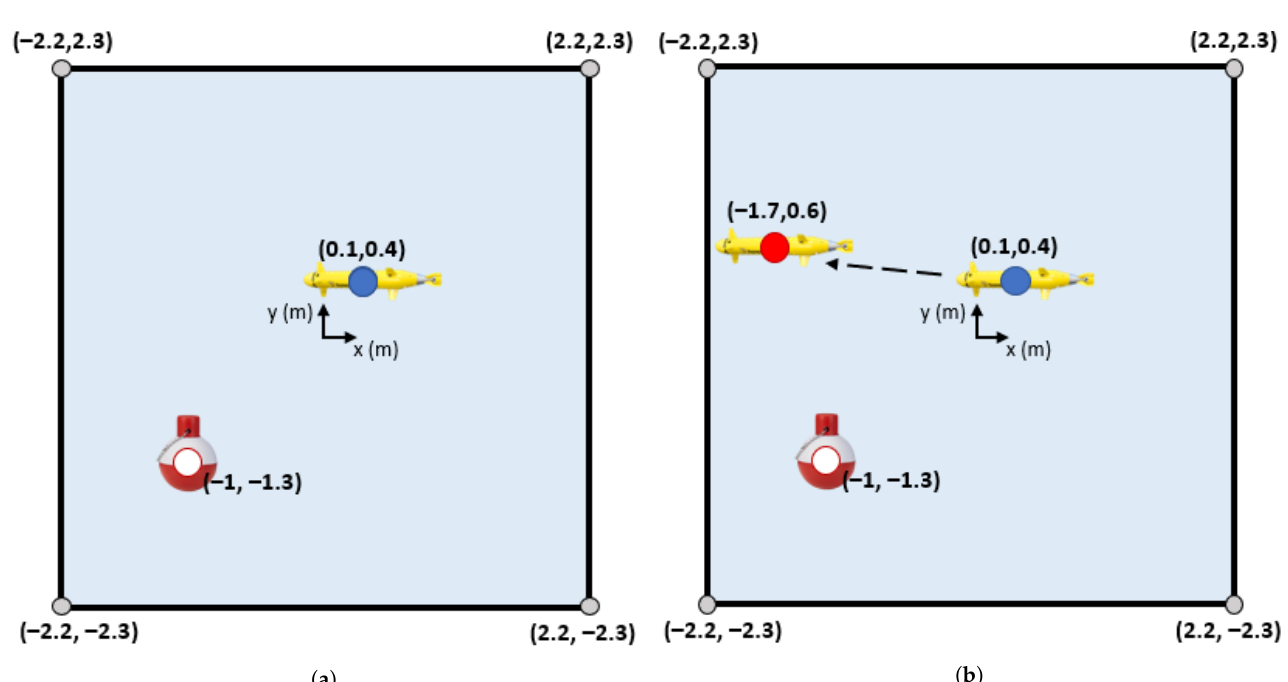
Figure 10. Illustration of the scenarios portrayed in each dataset. ( a ) Scenario for dataset 1 and ( b ) scenario for dataset 2, with initial (blue) and final (red) AUV positions marked.